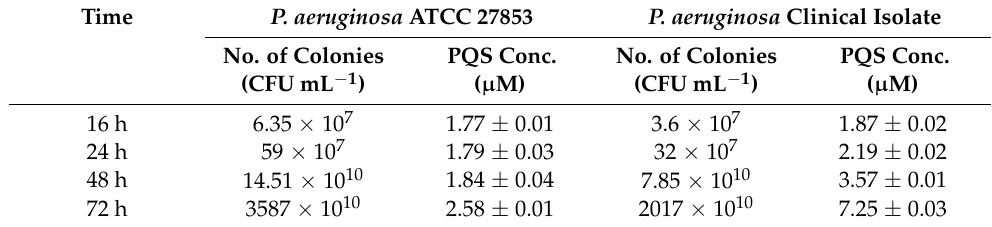
Table 5. P. aeruginosa cultures analysis.